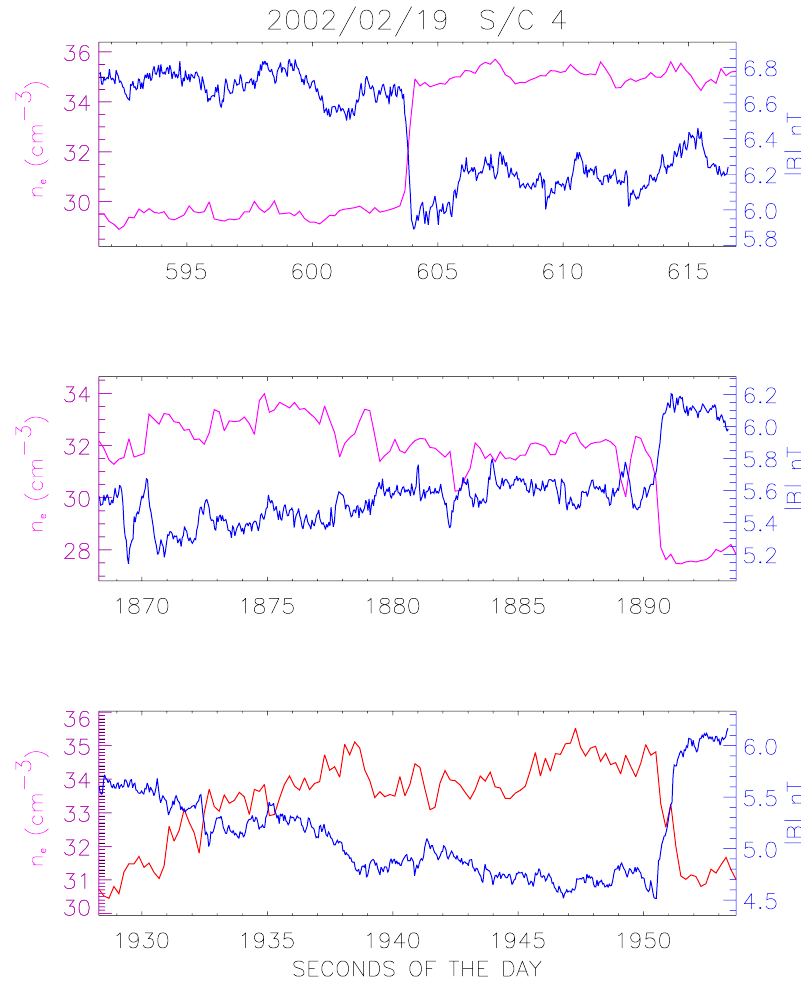
Fig. 9. Probable pressure balance